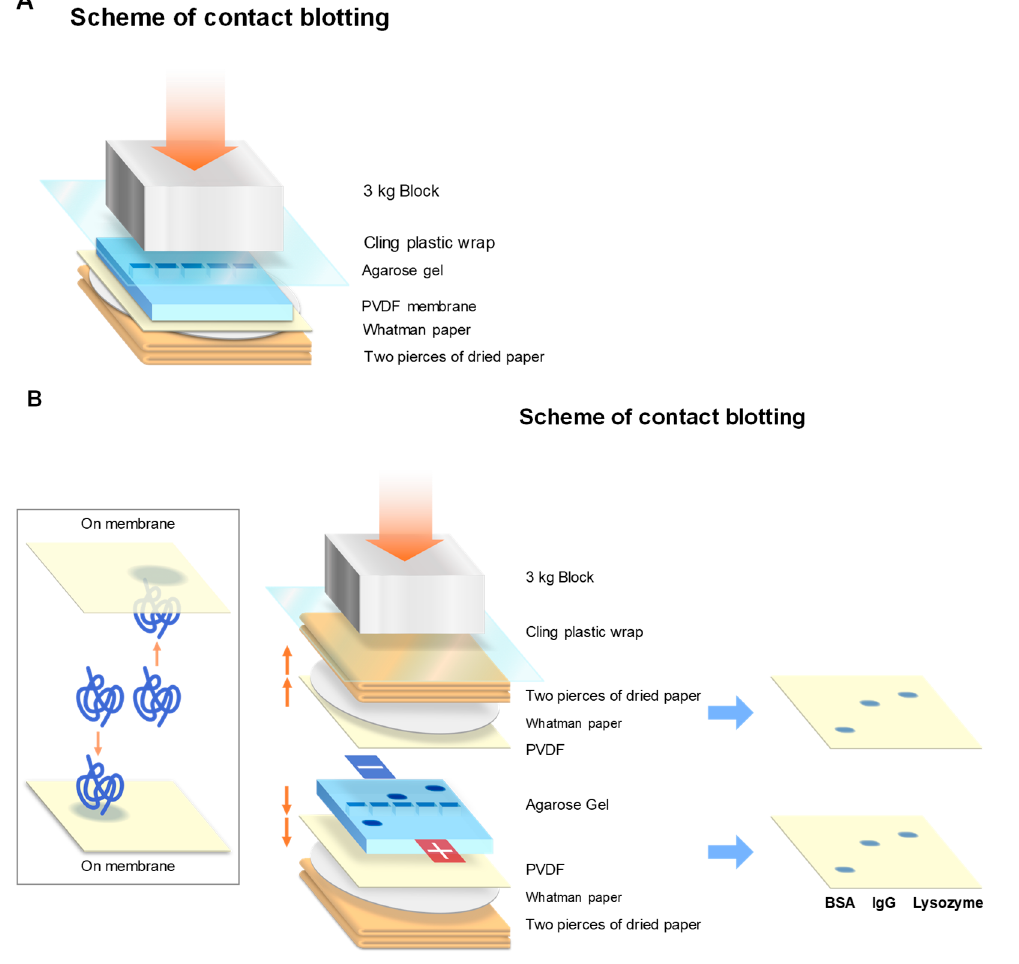
Figure 11. Scheme of contact blotting. ( A ) Contact blotting to PVDF membrane toward the bottom side. ( B ) Contact blotting to both upper and lower PVDF membranes. Typically, contact blotting was performed at room temperature for 5 min.